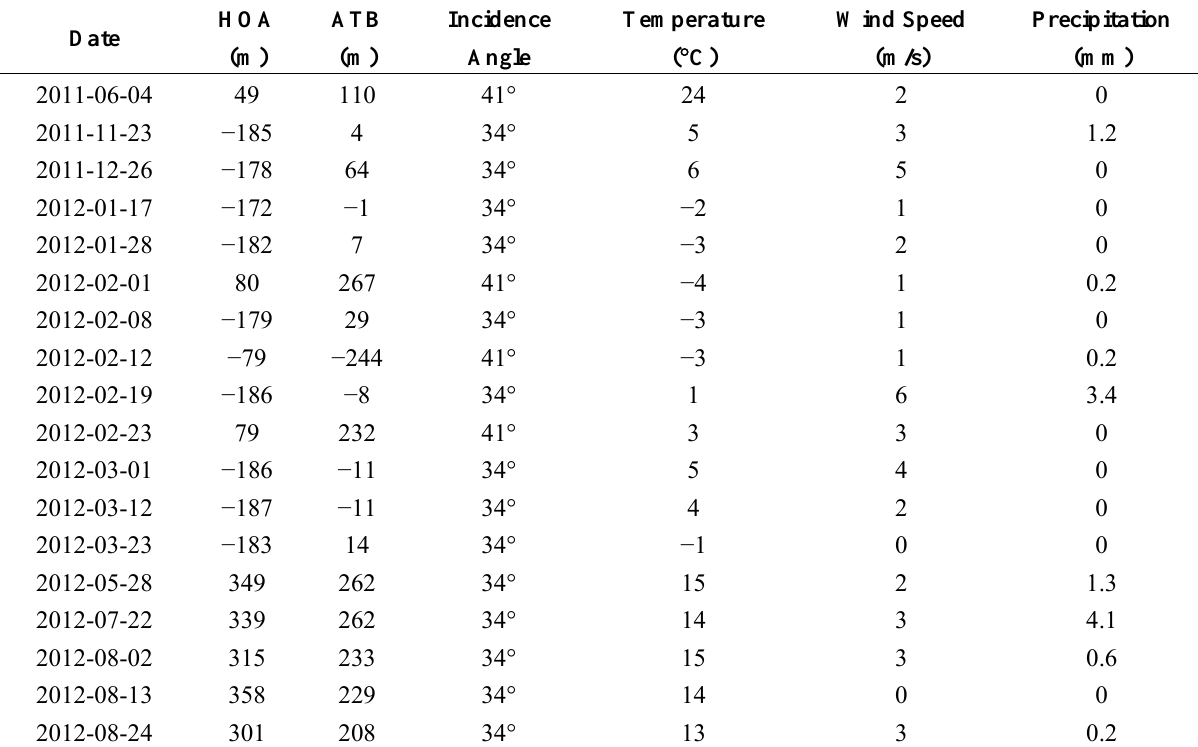
Table 1. TanDEM-X InSAR acquisitions and weather conditions at the time of image acquisition (HOA = Height of Ambiguity, ATB = Along-Track Baseline). The sign of HOA depends on the satellite positions, but has no relevance for the results in this